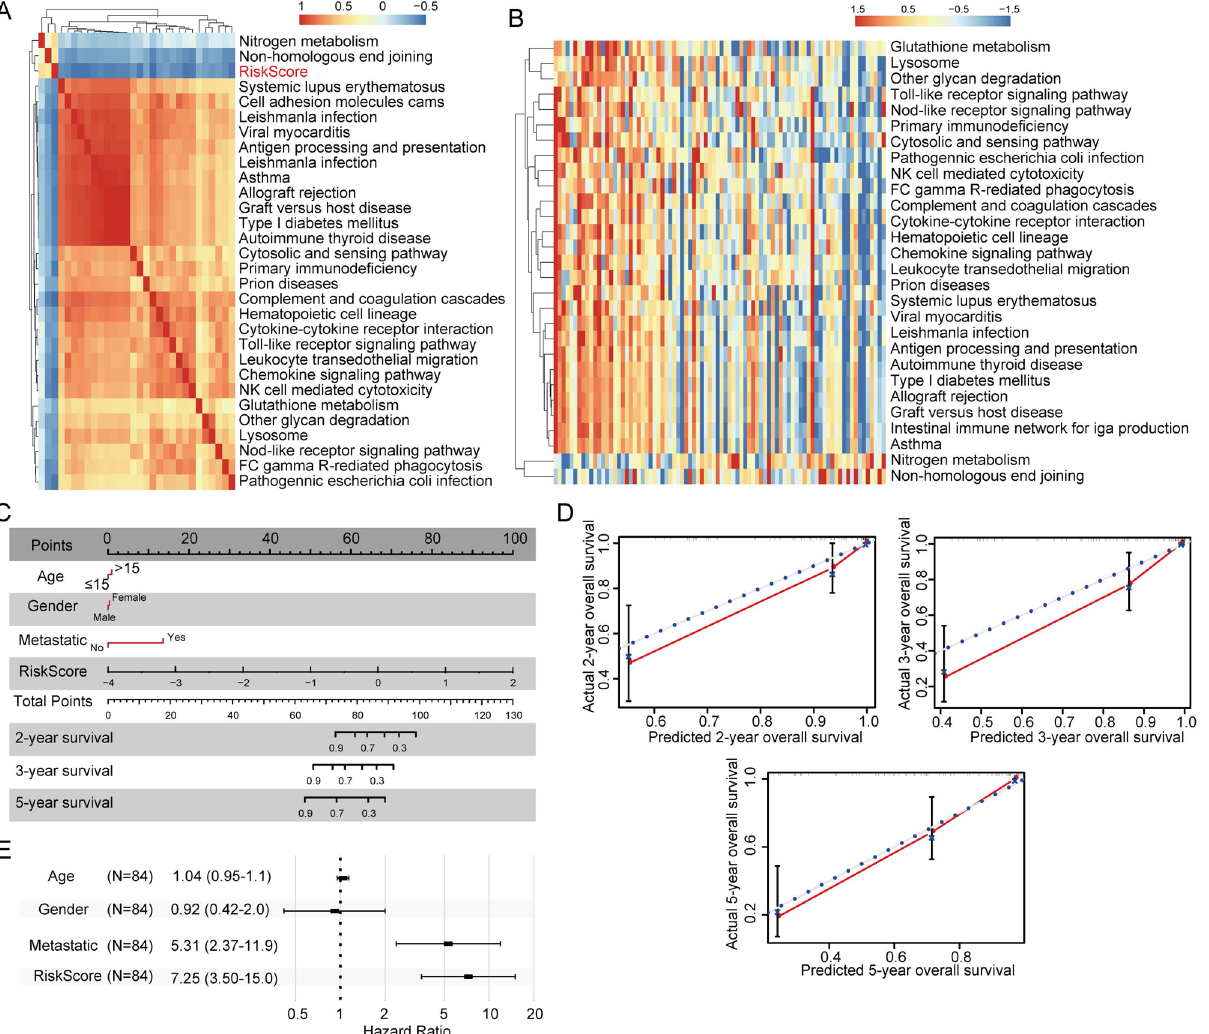
Figure 7. Relationship between the risk score and gene-related pathways and clinical features. ( A ) The relationship between the risk score and pathways as assessed with GSEA. ( B ) KEGG pathway analysis of the risk score. ( C ) Line chart of the risk score and clinical features. ( D ) Nomogram with correction based on the survival rate. ( E ) Forest plot of the risk score and clinical features. GSEA, gene set enrichment